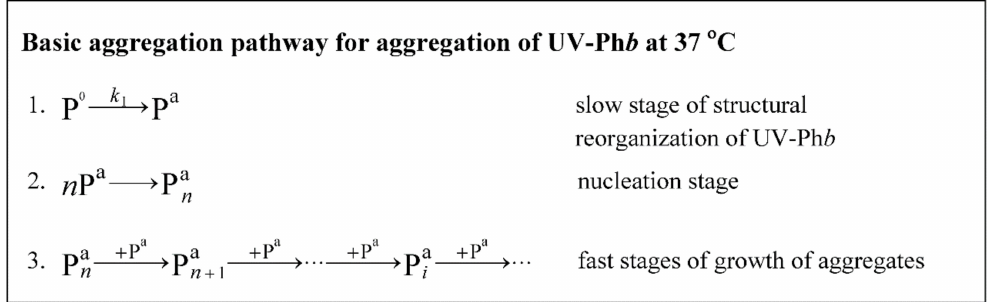
Figure 8. Scheme illustrating basic aggregation pathway for UV-Ph b aggregation at 37 ◦ C